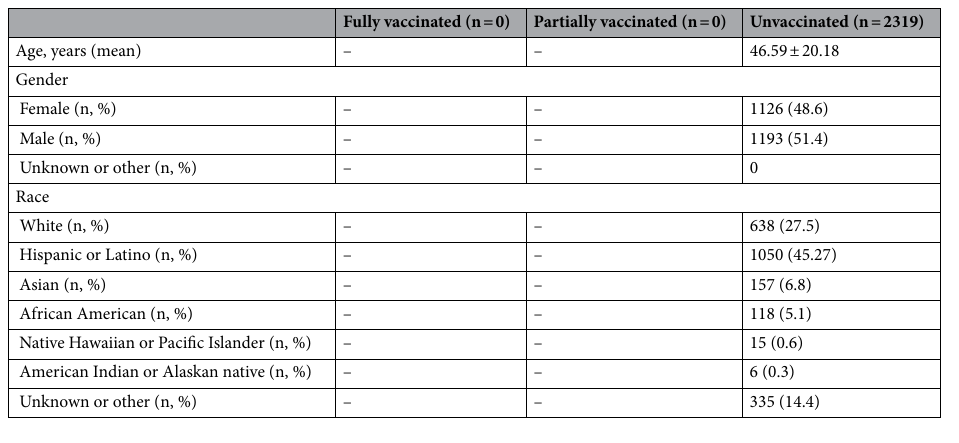
Table 1. Demographic information of patients with a positive SARS-CoV-2 result during the Founder variant wave (n = 2319 SARS-CoV-2